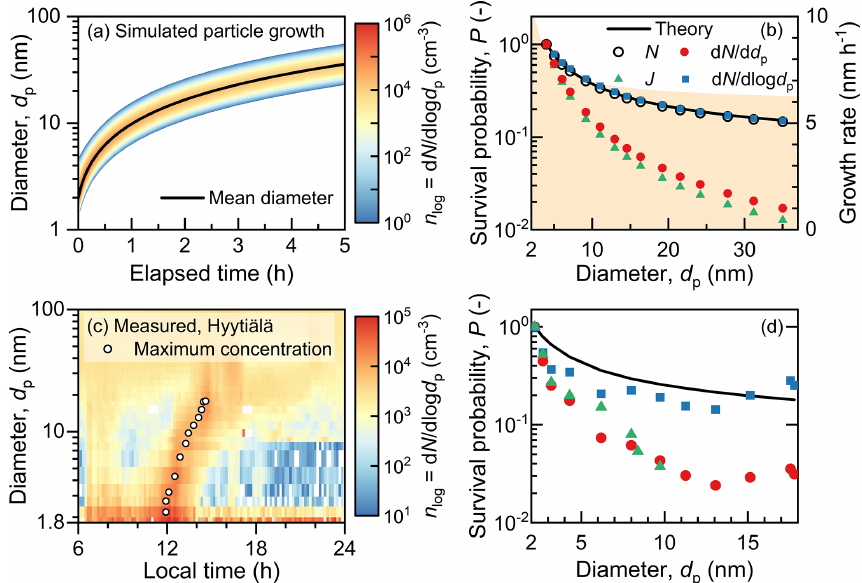
Figure 2. Survival probabilities of new particles in simulated and measured growing aerosol populations. (a) A growing size distribution of an aerosol population. There is no formation of new particles after the initial state. (b) The survival probability of new particles in the simulated aerosol population retrieved using different methods. (c) A banana-type NPF event measured from the boreal environment at Hyytiälä. A growth trajectory is retrieved using the maximum concentration method (Kulmala et al., 2012). (d) The survival probability of new particles in the measured NPF event. The theoretical lines in panels (b) and (d) are retrieved from the growth rate and the coagulation sink using Eqs. (2) and (3). The shaded area in panel (b) indicates the particle growth rate. The markers show the survival probabilities retrieved from the size distribution using Eqs. (1) and (4)–(6). Briefly, the retrieved survival probability is equal to X ( d p2 ) /X ( d p1 ), where X is N , d N/ d d p , J , or d N/ dlog d p